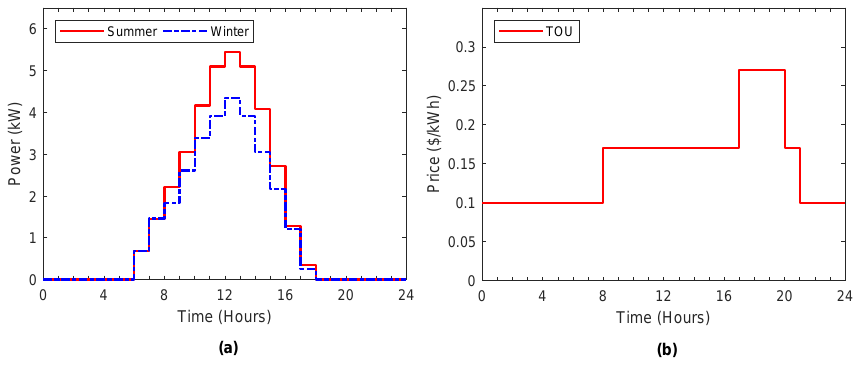
Figure 4. ( a ) Power output curve of solar in summer and winter; ( b ) TOU price signal. Near-real-time hourly electricity consumption data was collected from 48 states by the